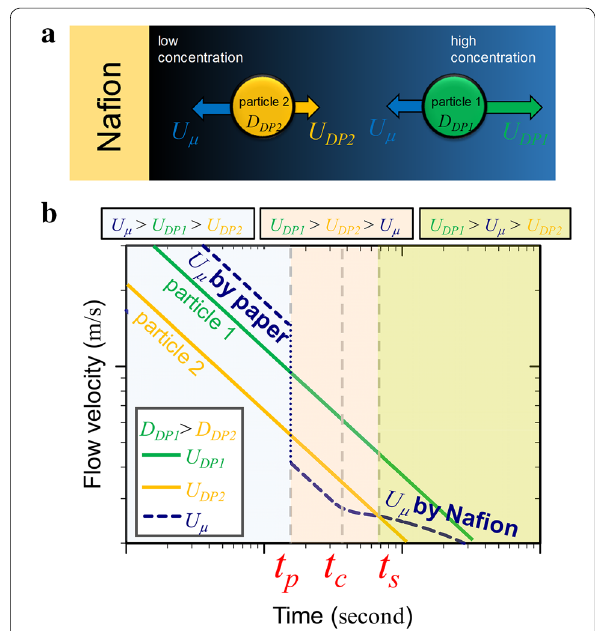
Fig. 2 a Schematic diagram of concentration gradient generated near the ion exchange medium (e.g. Nafion). b The plot of U DP s of particle 1 and 2 with different diffusiophoretic constant, and U μ induced by the imbibition of paper and